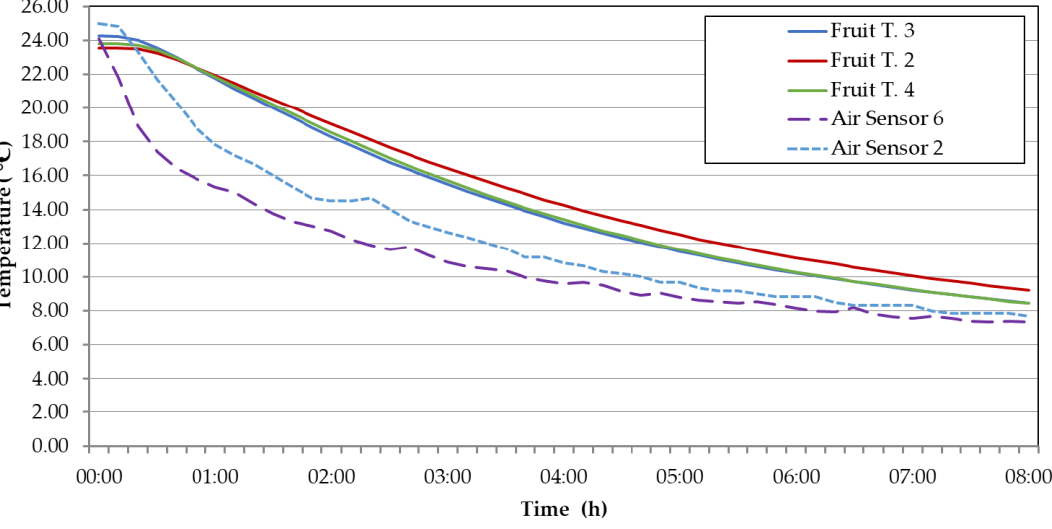
Figure 9. Thermal behavior in package 2, configuration B.